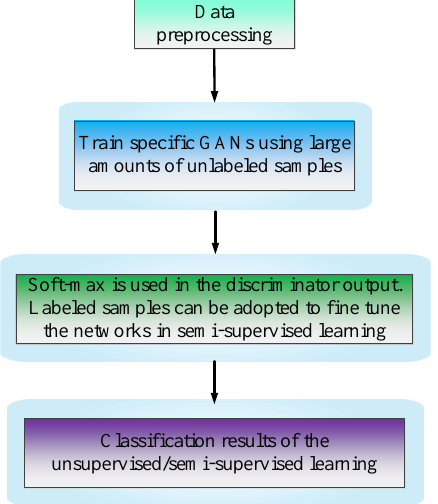
Figure 4. Schematic illustration of the procedure for unsupervised/semi-supervised learning based on